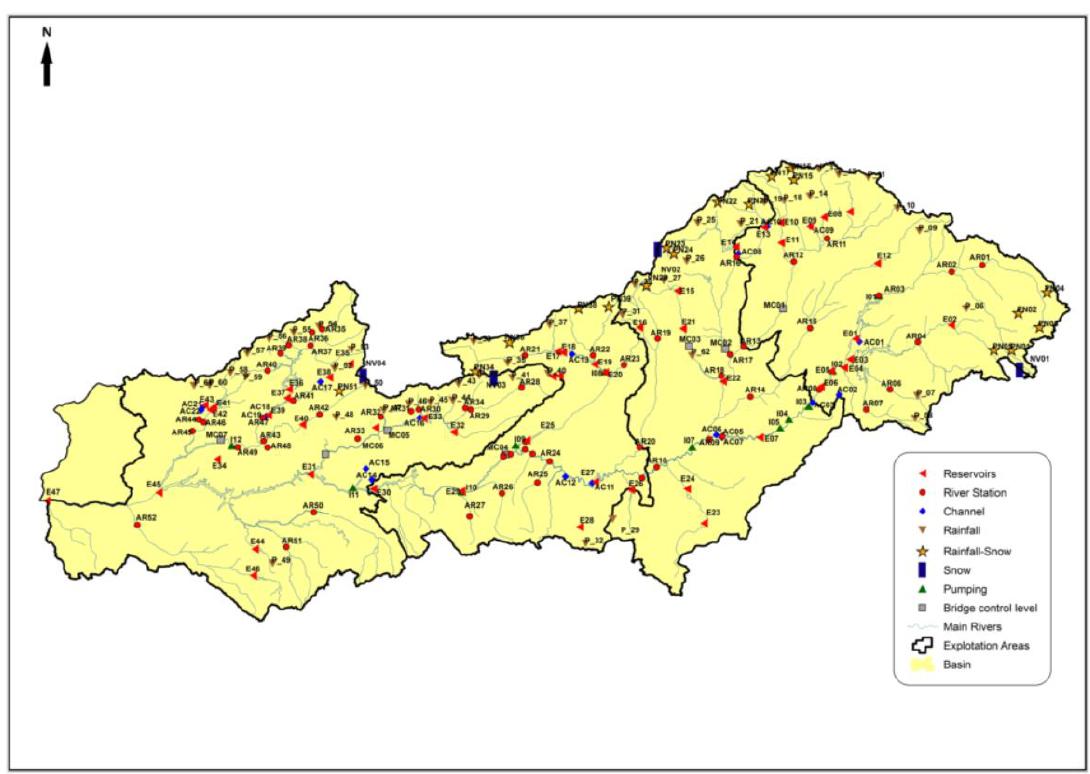
Figure 3. SAIH network control points—Tagus Basin.